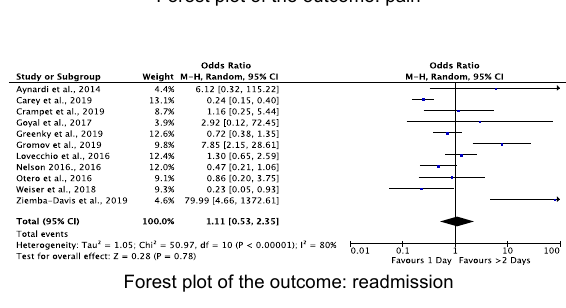
Forest plot of the outcome: pain